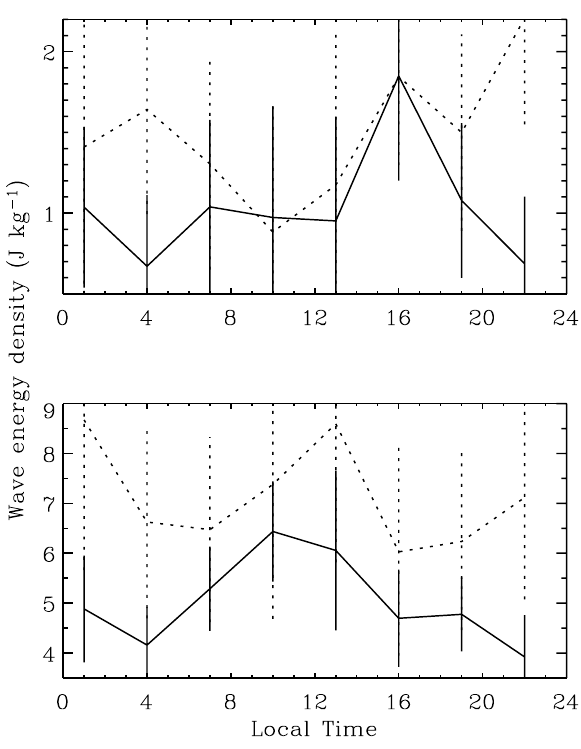
Fig. 8. Similar to Fig. 4, but for GWs in January